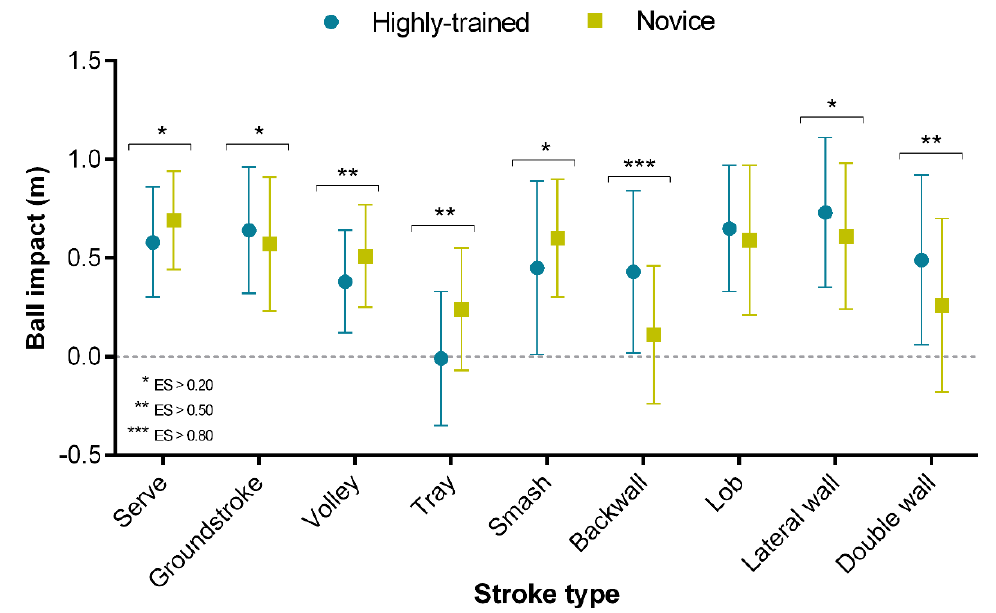
Figure 3. Differences in ball impact position (y-axis, in m) and different stroke types (x-axis) between highly trained and novice padel players (markers). Data from 14,798 strokes. Asterisks indicate significant mean differences ( p < 0.05) at small, middle, and large effect size (ES).